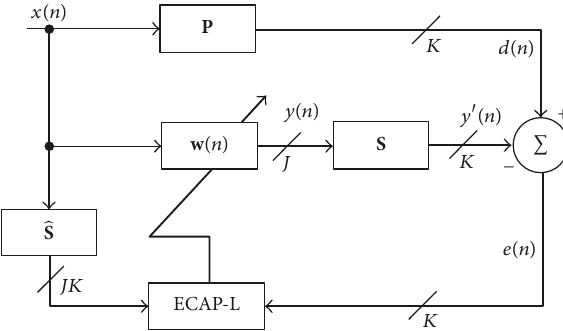
Figure 1: Block diagram of the Filtered-X ECAP-L algorithm for an ANC system